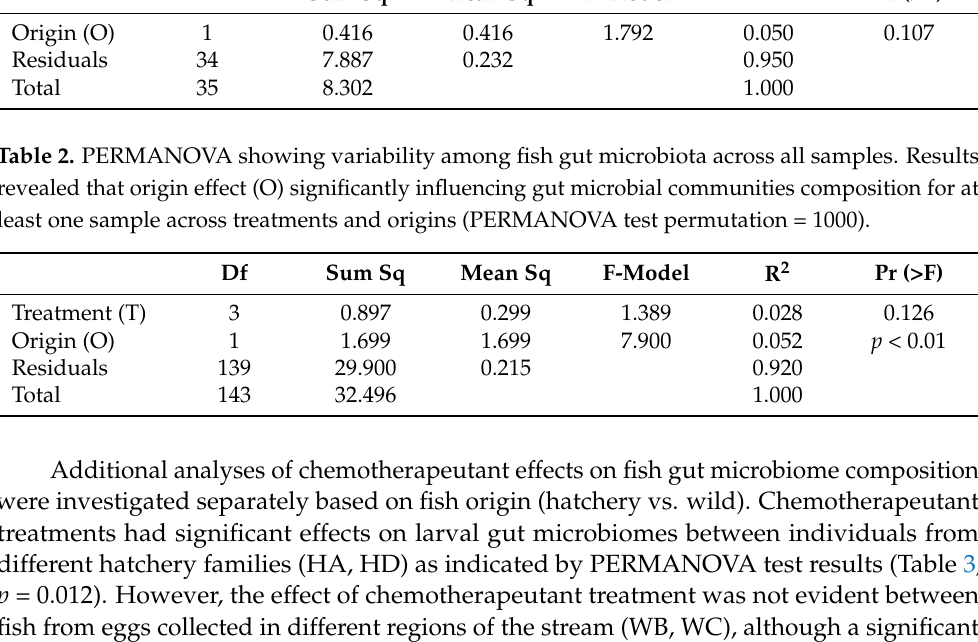
Table 1. PERMANOVA showing variability among fish gut microbiota across control groups only. Df Sum Sq Mean Sq